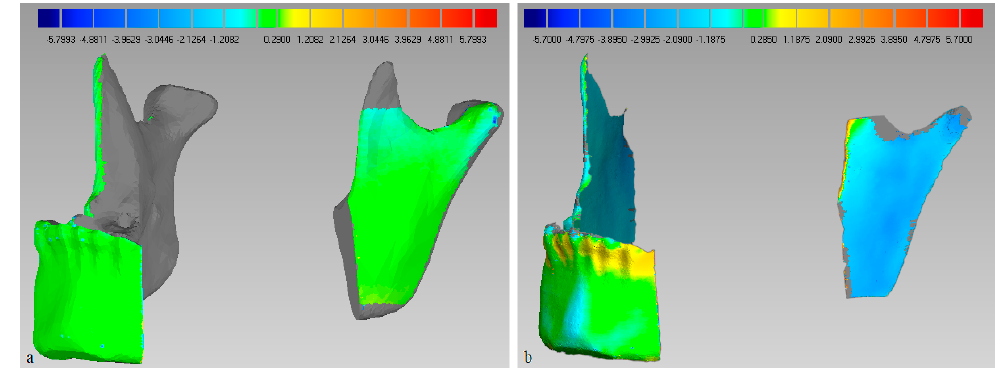
Figure 14. The 3D comparison results for physical prototypes with ( a ) Cavity-filled with resected comparison ( b ) Mirror with resected comparison.